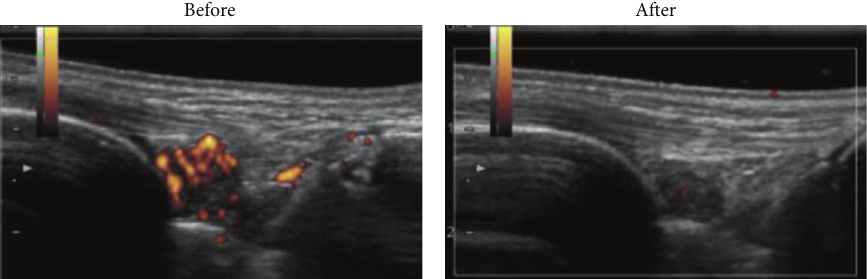
Figure 1: A representative result of US of the wrist of case 3 demonstrated PD-positive synovitis before treatment with CZP. US showed disappearance of PD-positive inflammatory synovitis after treatment with